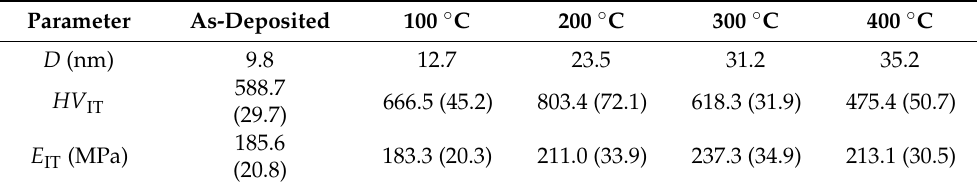
Table 1. The estimated crystallite size ( D ), indentation microhardness ( HV IT ) and indentation modulus of elasticity ( E IT ) of Ni coatings depending on the heat treatment temperature. Parameter